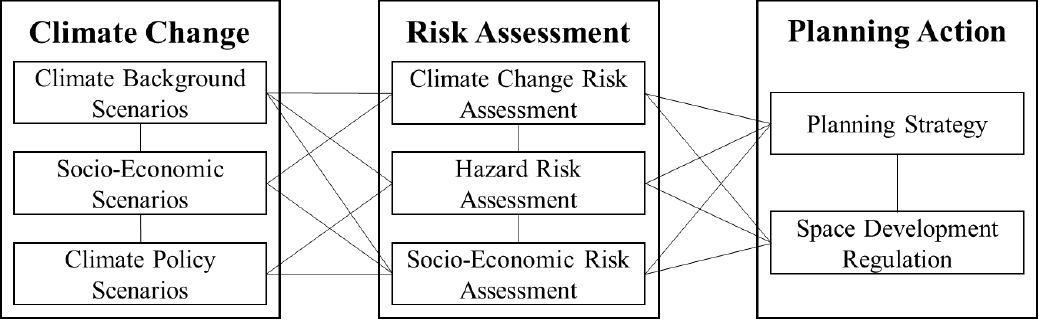
Figure 8. Adaptation framework of Guiyang MTSP.